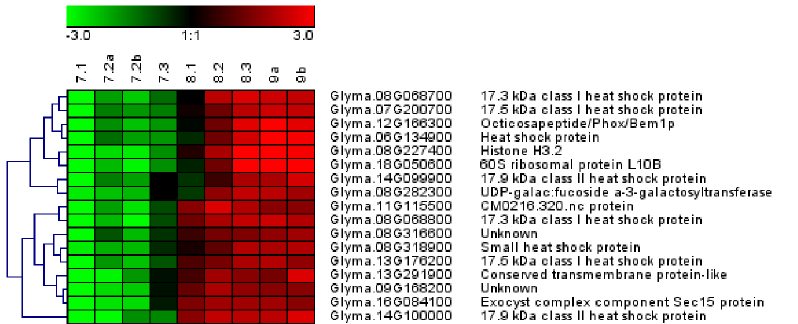
Fig 8. Heat map of most differentially expressedgenes correlating with longevity. Genes were retained when the log2 intensity > 4 betweenstage 7.2 and 9 and that correlate with longevity(PPC P50 > 0.85). Genes were log2 mean centeredand colored from the lowest (green) to highest values (red).